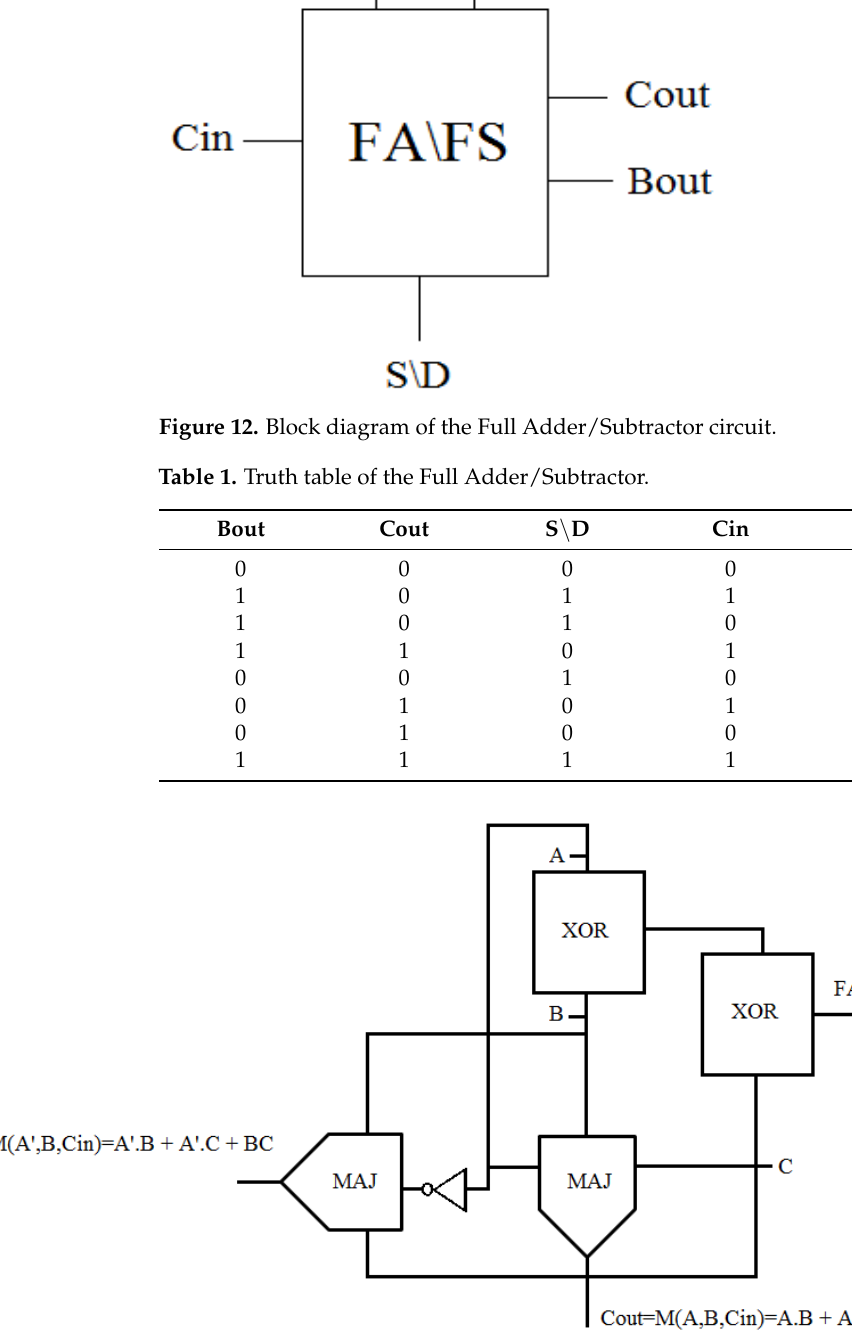
Figure 14. The proposed (A) Full Adder/Full Subtractor circuit.